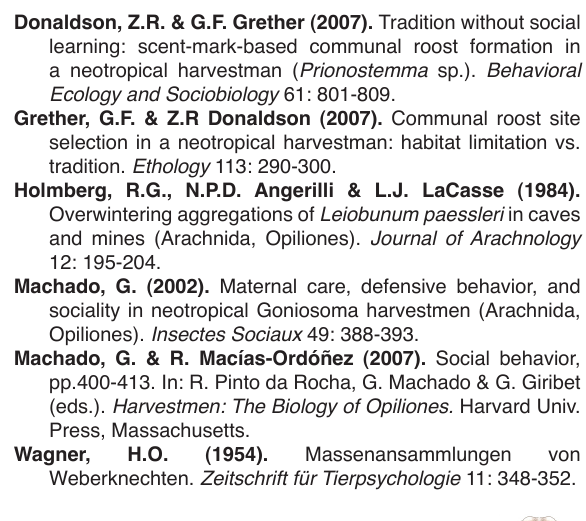
temperate zone during chilling winter may be comparable to the temperatures under which the aggregation occurs in the ground-vegetation of a seasonal